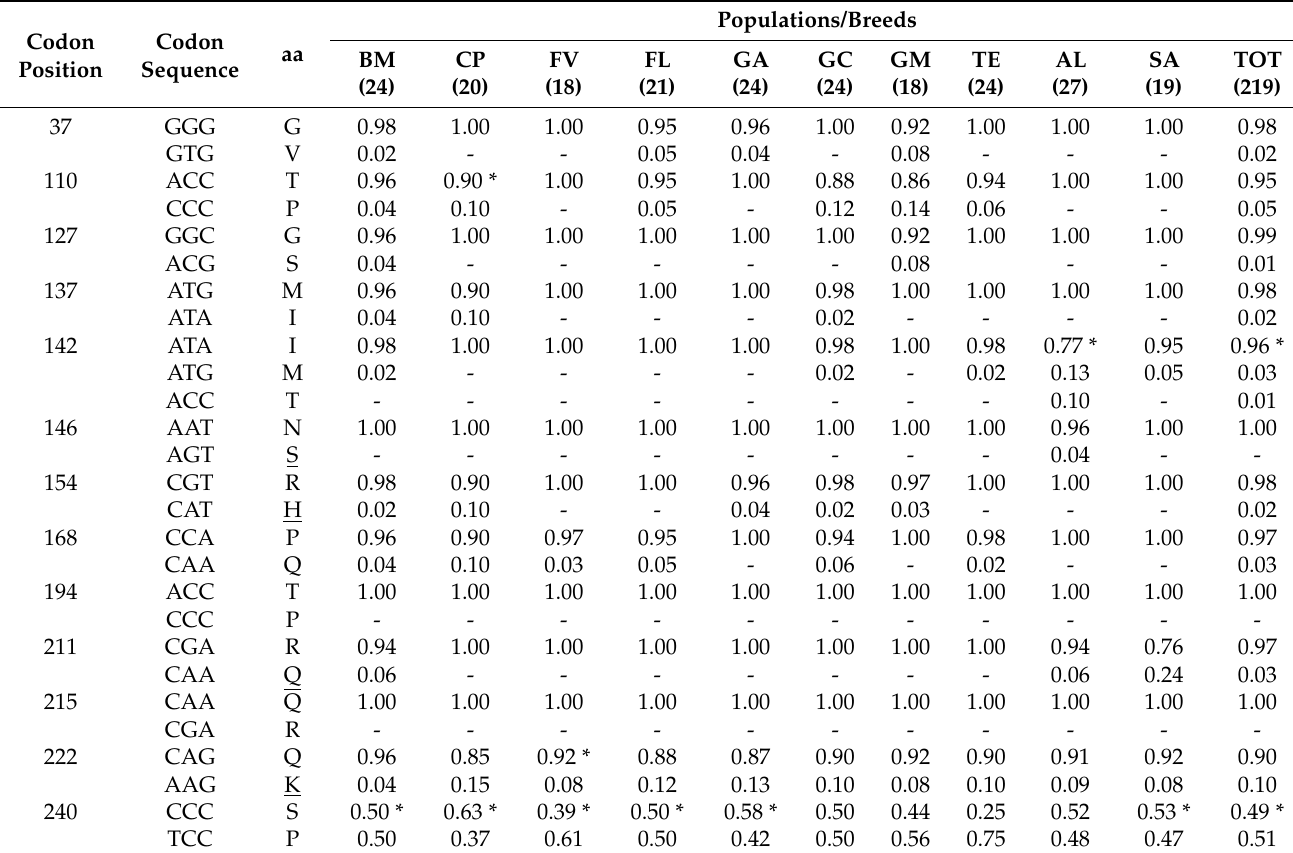
Table 1. Allele frequencies of PRNP polymorphisms (given as a fraction of unit) in the studied populations/breeds (highlighted in grey: variants). The number of animals is reported in brackets.